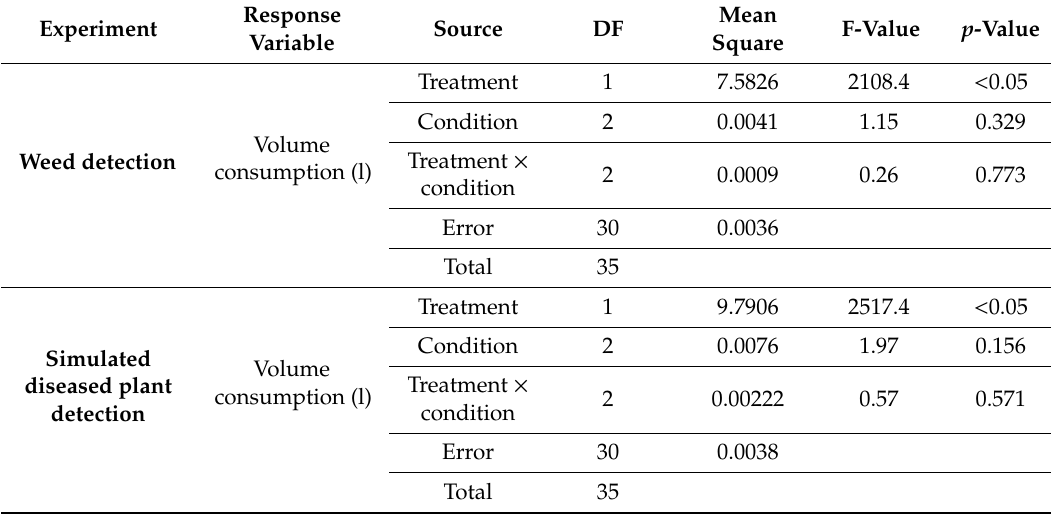
Table 4. The two-way ANOVA results showing the e ff ects of spraying techniques (the treatments) and weather conditions (cloudy, partly cloudy, and sunny) and their interaction (treatment × condition) on volume consumptions for spraying during weed and simulated disease